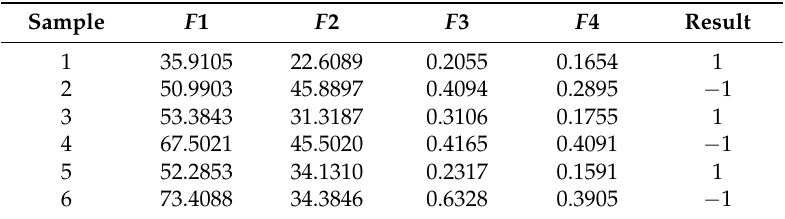
Table 2. Test results of support vector machine